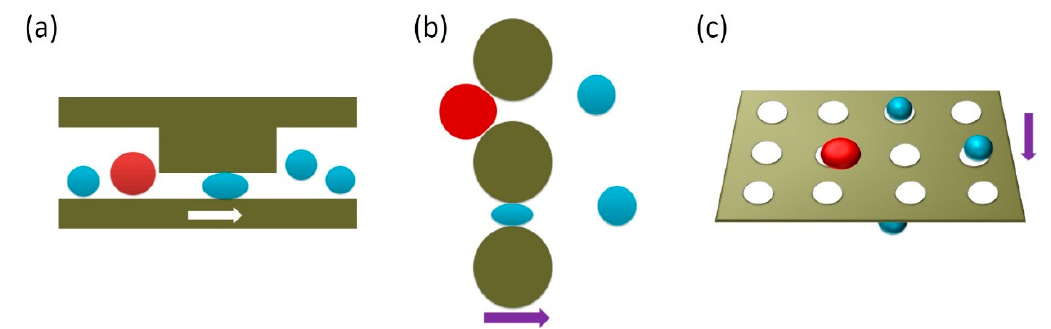
Figure 6. Illustration of the filtering microstructures in microdevices, including ( a ) weir, ( b ) pillar, and ( c ) pore. Red circles represent the CTCs and blue circles indicate the leukocytes, which are relatively small and easily deformed.